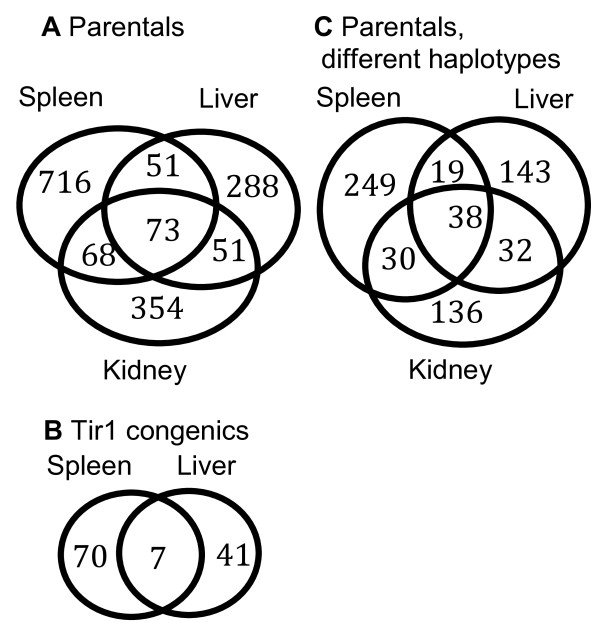
Venn diagrams, showing the numbers of genes differentially expressed in each tissue. A Parental A/J vs C57Bl/6, B Congenic Tir1AA vs Tir1CC, C genes in the parental lines which occur on different haplotypes and are differentially expressed. In all cases most genes were differentially expressed in only one of the tissues. Differential expression was defined as absolute log2 fold change > 0.5 and pplr < 0.005.